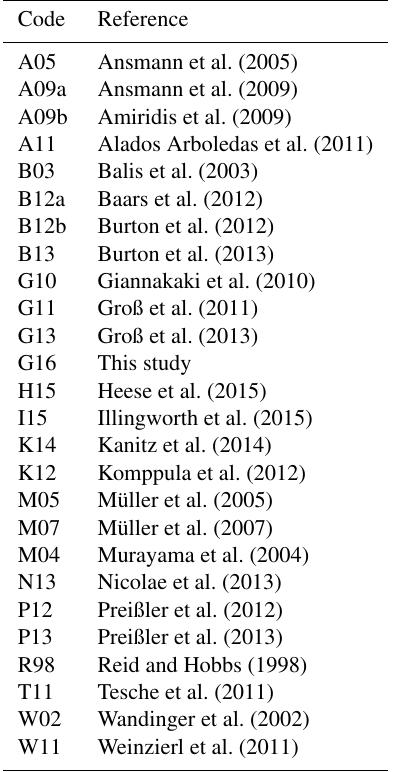
Table 4. The code used in Fig. 7 and the respective